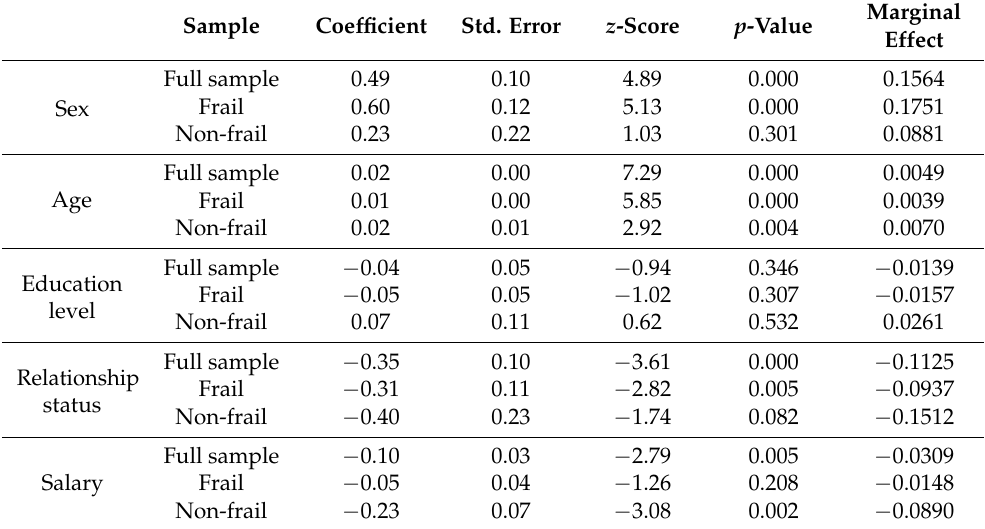
Table 2. Probit models for effects of sociodemographics on heart failure occurrence across the full sample and each subsample. The full sample includes participants with heart failure and those in the healthy control group. The table includes parameters, significance levels and marginal effects of the probit model built to explain effects of the five demographic variables (sex, age, education level, relationship status and salary) on heart failure